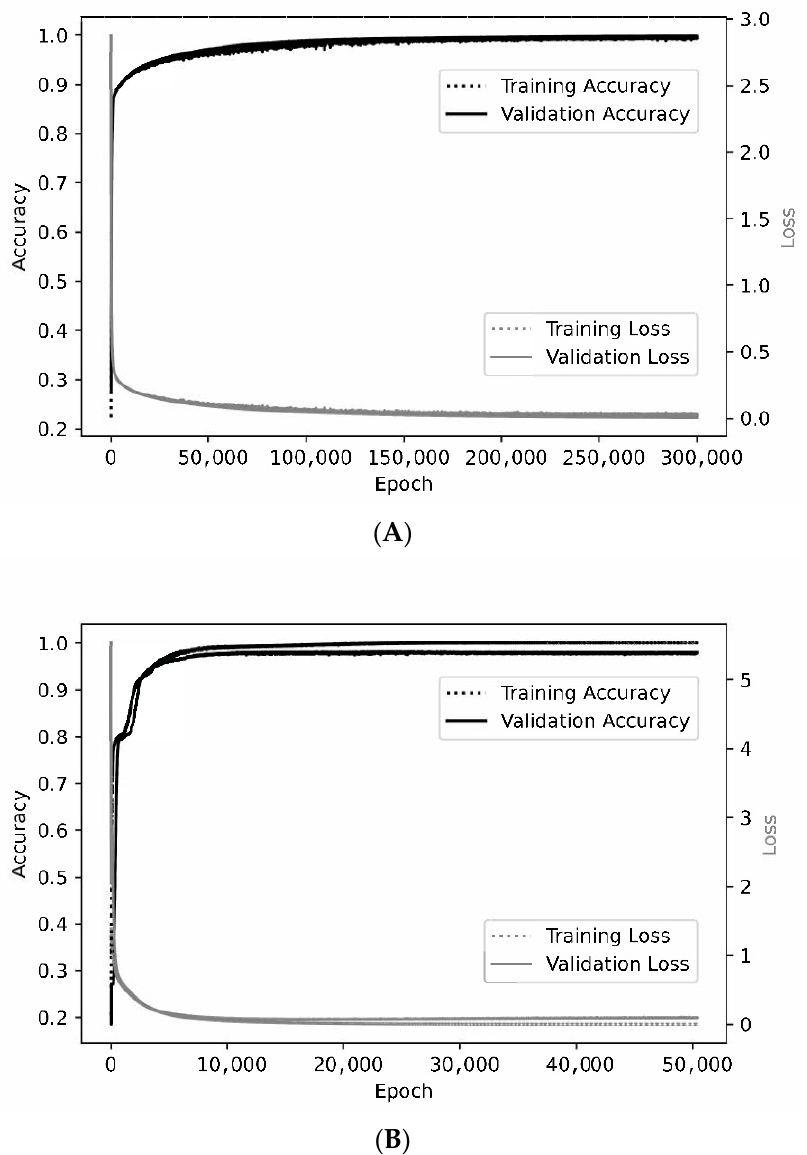
Figure 5. Representative learning curves. For the smallest patch size of 3 × 3 × 3 × 2 ( A ), the training and validation curves are nearly superimposed when assessing either accuracy or loss. At a patch size of 7 × 7 × 7 × 2 ( B ), optimal training accuracy and loss are slightly better than for validation. Table 2. Confusion matrices and detailed test performance characteristics a at different combinations of X and Z.